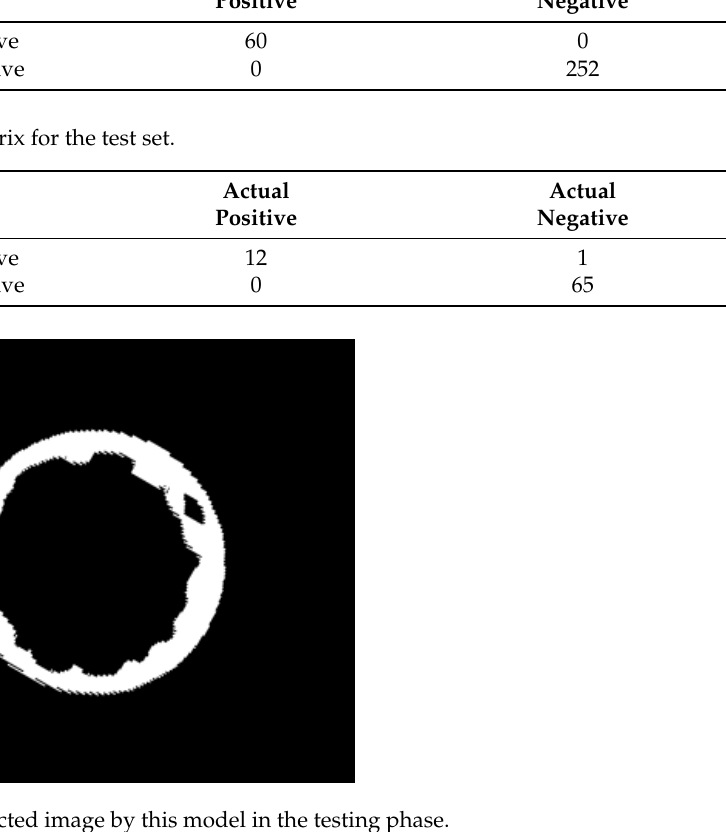
Figure 11. Poorly predicted image by this model in the testing